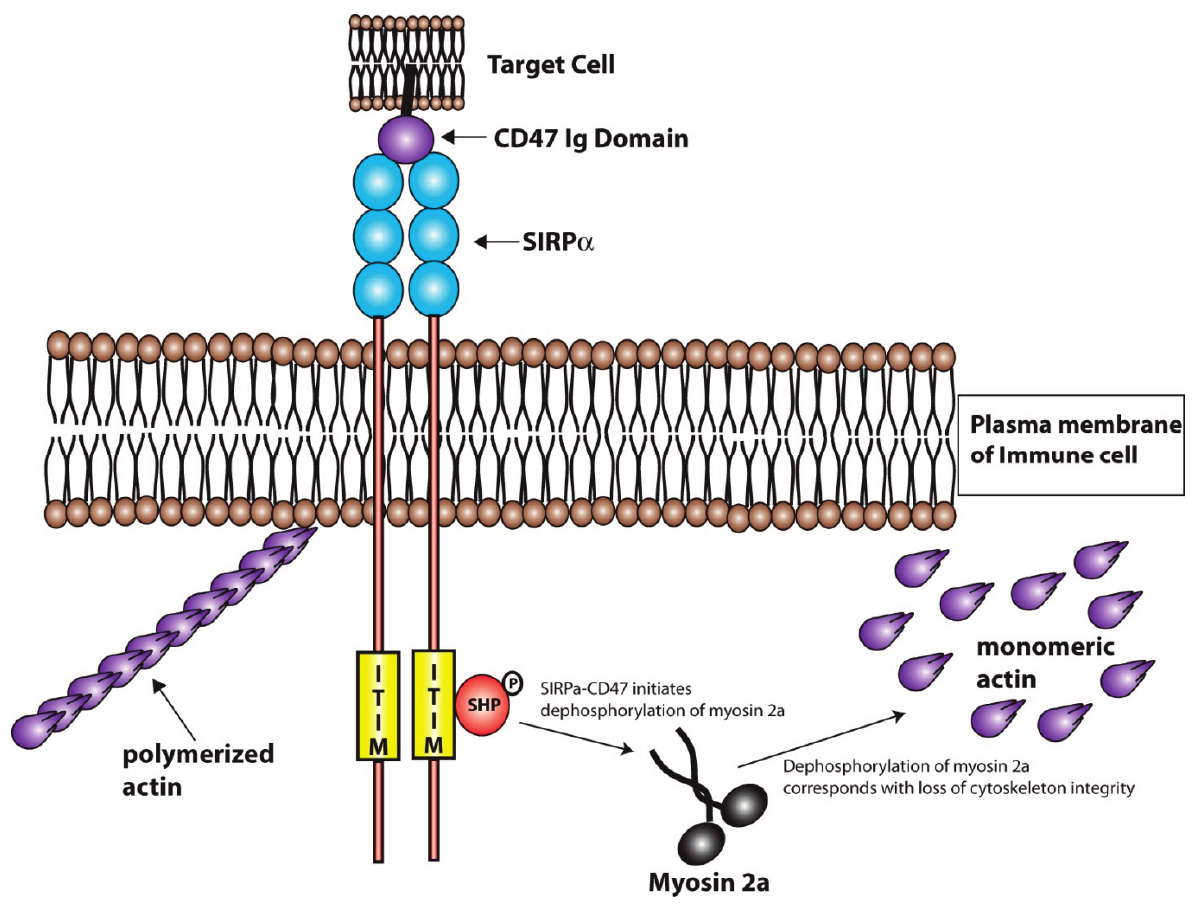
Figure 3. Signaling downstream of the SIRP α -CD47 Interaction. The interaction between CD47 and SIRP α activates the SIRP α ITIM domain via transphorylation events. This leads to the activation of SHP, the deactivation of myosin 2a, and initiates the depolymerization of actin within the immune cell. The depolymerization of actin is involved in inhibition of immune cell attachment and the phagocytosis of the CD47-bearing cell or